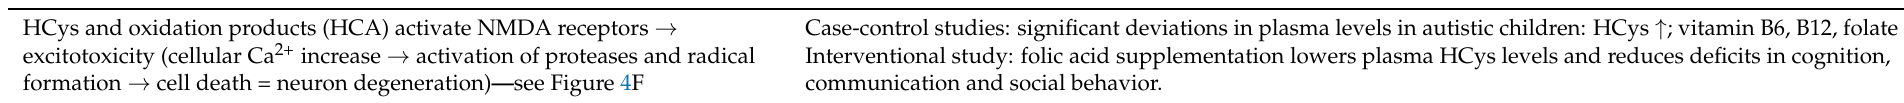
Table A5. Autism— Rev